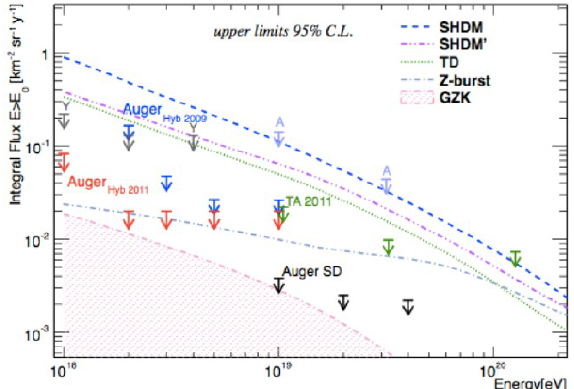
Figure 4: Upper limits on the integral photon flux. Different expectations are shown for